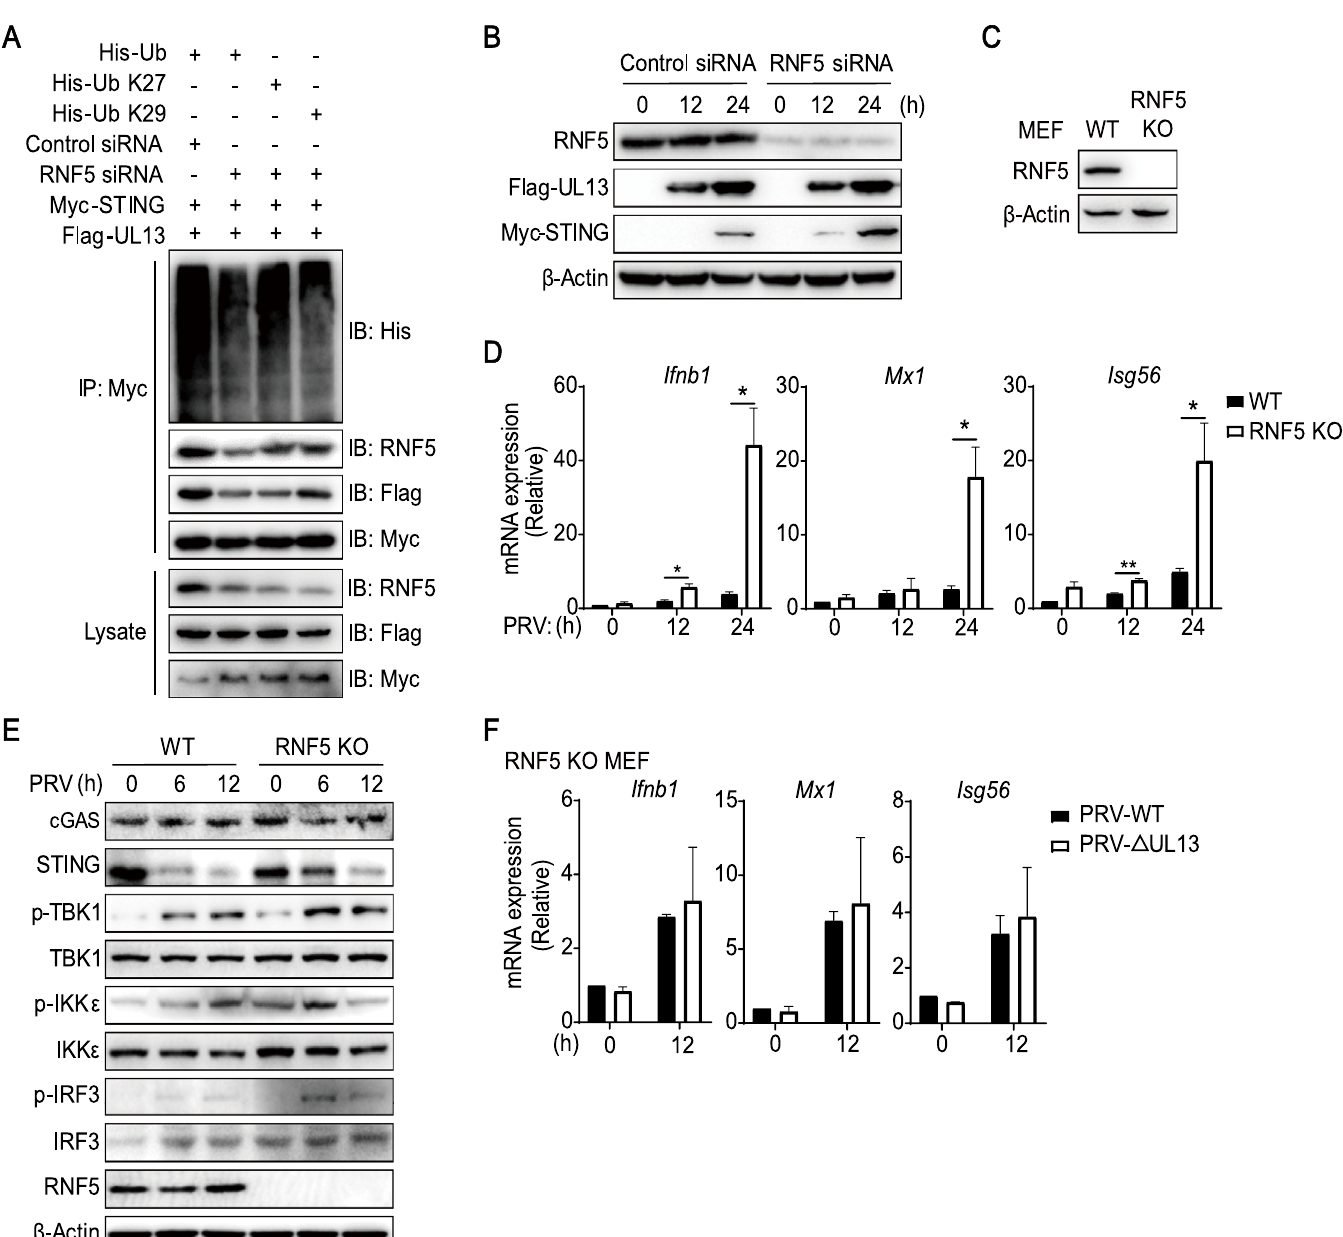
Fig 6. RNF5-deficiency potentiates PRV-induced antiviral immune responses. (A) Immunoblotting analysis of indicated proteins in immunoprecipitated samples and whole-cell lysates of HEK293T cells transfected with RNF5 siRNA or control siRNA (50 μ M). Twenty-four hours after transfection, cells were further transfected with Flag-UL13, Myc-STING, and His-Ub for another 24 h before analysis. (B) Immunoblotting analysis of protein levels of RNF5, UL13, and STING in whole-cell lysates of HEK293T cells transfected with RNF5 siRNA or control siRNA for 24 h. Cells were then transfected with Flag-UL13 and Myc-STING for the indicated times (above lane). (C) Immunoblotting analysis of RNF5 protein expression in wild type (WT) and RNF5-deficient (RNF5 KO) MEFs. (D) qPCR analysis of transcription of Ifnb1 and downstream genes ( Mx1 , Isg56 ) in WT and RNF5 KO MEFs infected with PRV (MOI = 1) for the indicated times. (E) Immunoblotting analysis of cGAS, STING, phosphorylated (Ser172) and total TBK1 and IKK ε , phosphorylated (Ser396) and total IRF3, or RNF5 in whole-cell lysates of WT and RNF5 KO MEFs infected with PRV (MOI = 1) for the indicated times. (F) qPCR analysis of mRNA expression of Ifnb1 and downstream genes ( Mx1 , Isg56 ) in RNF5 KO MEFs infected with PRV-WT or PRV- Δ UL13 (MOI = 1) for indicated times. Data are representative of two (A, C) or three (B, E) independent experiments, or are pooled from three independent experiments (D, F, mean ± SD). � p < 0.05, �� p < 0.01 (Student’s t test).